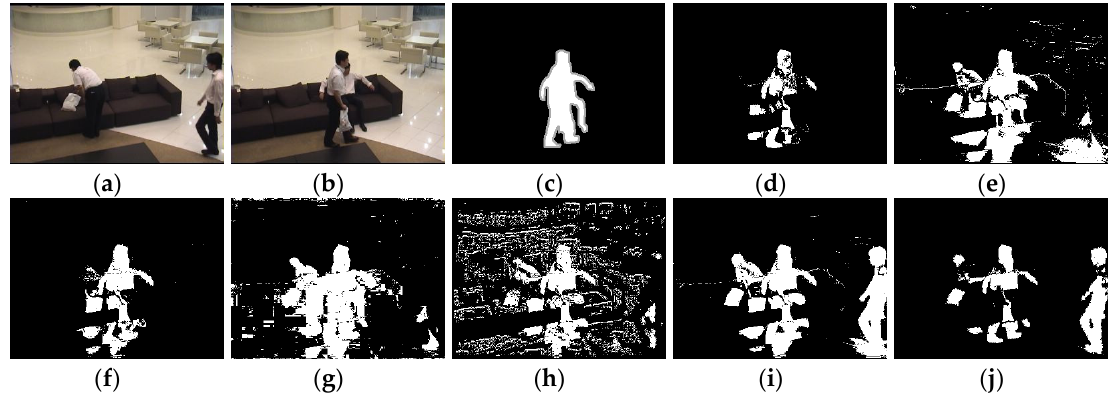
Figure 12. Comparison of segmentation results of seven background subtraction methods for one frame taken from the sofa sequence. ( a ) Frame n (start image), ( b ) frame n + 99, ( c ) ground ‐ truth, ( d ) EBBE (proposed), ( e ) codebook, ( f ) GMM, ( g ) KDE, ( h ) PBBE, ( i ) SOBS, and ( j ) ViBe.